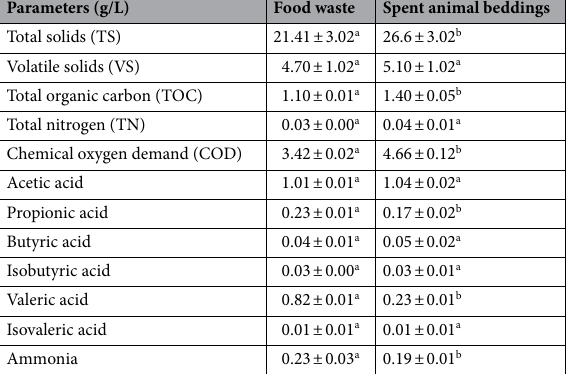
Table 2. Characteristics of effluent from food waste and spent animal beddings treatment in fuel cells (first phase). Values shown in table are means of triplicate analyses with respective standard errors; superscripts with same letters are statistically the same by the Tukey’s test at